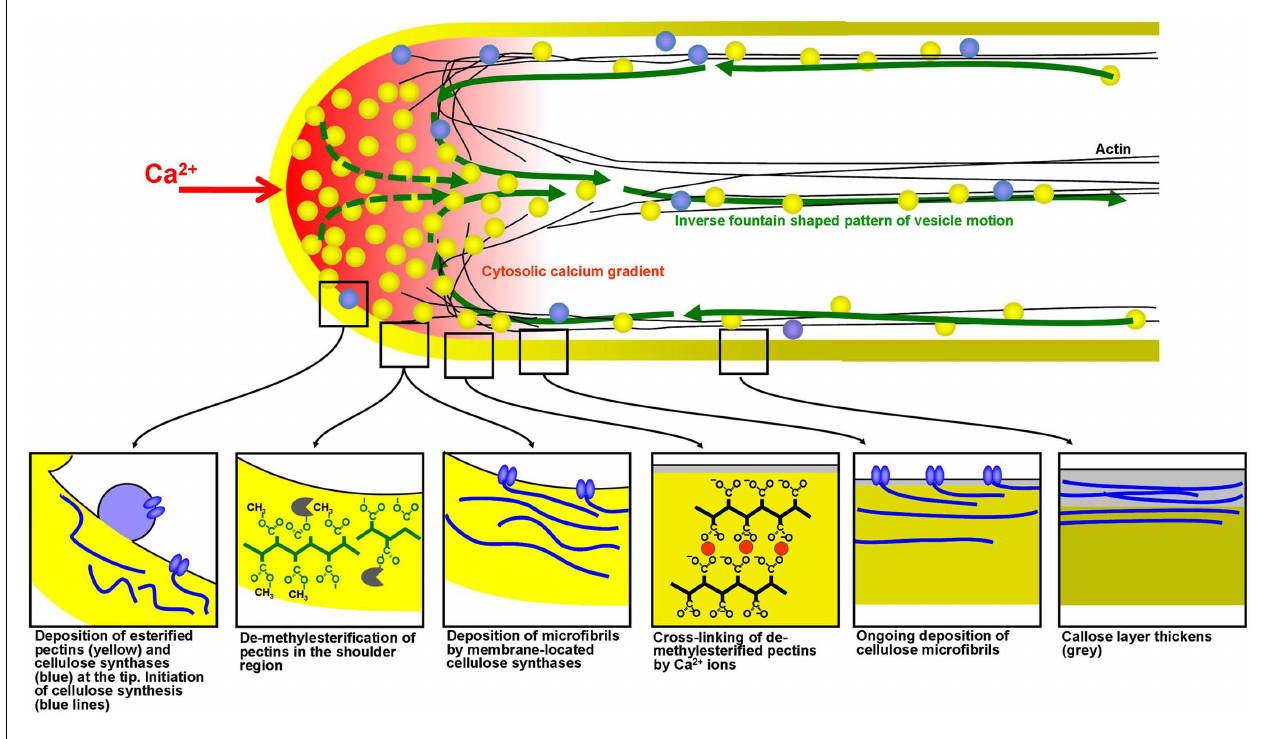
determines the cellular morphogenesis, and the resulting shape in growing plant cells.These processes occur particularly rapidly in pollen tubes making them an ideal model system for experiments based on short-term exposure to